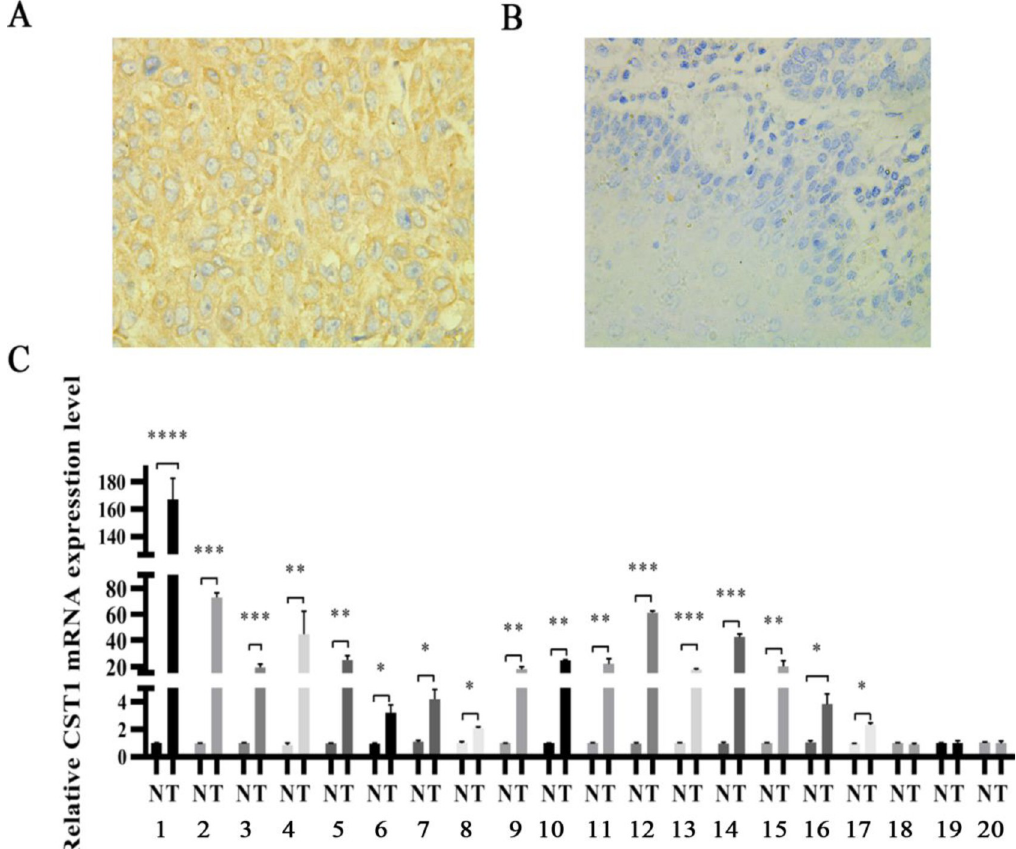
Fig 2. The expression of CST1 in cancerous and paired paracancerous tissues of ESCC patients (A) Positive expression of CST1 in ESCC cancer tissues ( × 400). (B) Negative expression of CST1 in paracancerous tissues ( × 400). (C) Relative expression of CST1 mRNA in 20 pairs of cancer tissues and paracancerous tissues. ( � P < 0.05, �� P < 0.01, ��� P < 0.001, ���� P < 0.0001).